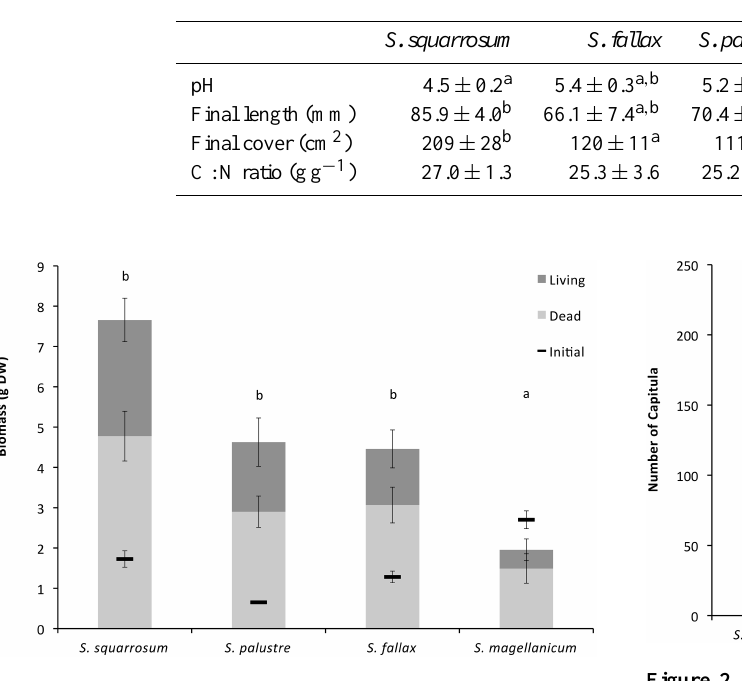
Figure 1. The biomass dry weight (DW ± SEM) produced by a patch of 50cm 2 of four different Sphagnum species after 12 weeks of experimental treatments, divided into living and dead tissue (dark and light bars, respectively). The smaller black bars represent ini- tial DW. Significant differences between total final biomass of the species are indicated by different letters ( P = 0.005).